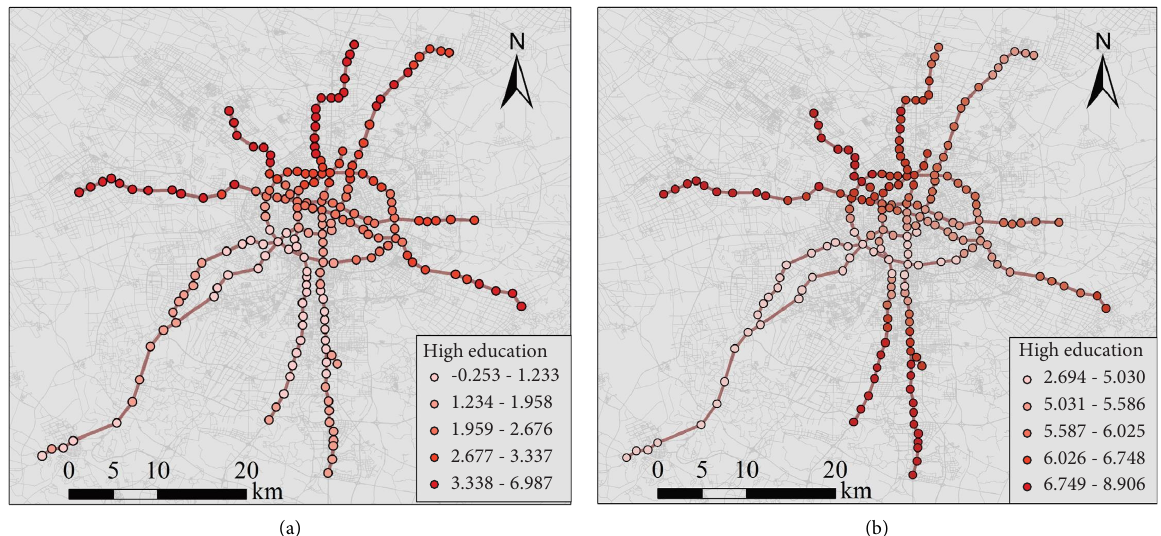
Figure 10: Spatially varying efects of high education on the access/egress distance. (a) Efects of high education on the access distance and (b) efects of high education on the egress